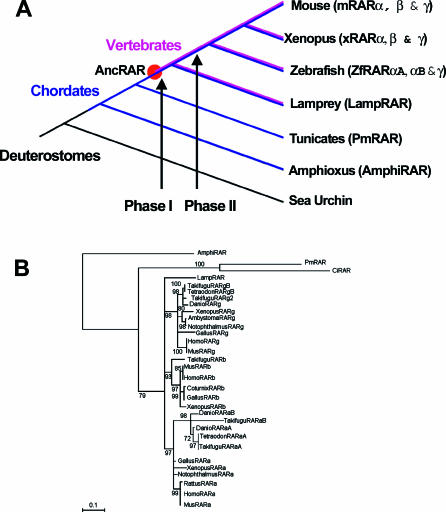
Phylogenetic View of Deuterostomes and RARs(A) Current view of deuterostome phylogeny with amphioxus representing the basal chordate [5]. RARs used in the present study are indicated at their respective taxonomic positions—for mouse, Xenopus, zebrafish, lamprey, amphioxus, and tunicates. The position of the synthetic ancestral sequence is indicated by a red circle. The two proposed periods of whole genome duplications in vertebrates are indicated as Phase I and Phase II, occurring respectively before and after the divergence of lampreys.(B) Phylogenetic tree showing the placement of the RARs used in this study. Branch length is proportional to evolutionary change (bar = 0.1 substitutions per site); numbers at nodes are bootstrap support, in percent of 1,000 replicates. Branches supported by bootstrap lower than 70% have been polytomised. The tree was rooted by the amphioxus sequence, in agreement with [5]. Species abbreviations and their groups are indicated as follows. Amphioxus: Amphi, Branchiostoma floridae. Tunicates: Pm, Polyandrocarpa misakiensis; Ci, Ciona intestinalis. Lampreys: Lamp, Petromyzon marinus. Teleost fish: Takifugu, Takifugu rubripes; Tetraodon, Tetraodon nigroviridis; and Danio, Danio rerio. Amphibians: Xenopus, Xenopus laevis; Ambystoma, Ambystoma mexicanum; and Notophthalmus, Notophthalmus viridescens. Birds: Gallus, Gallus gallus; and Coturnix, Coturnix coturnix. Mammals: Homo, Homo sapiens; Mus, Mus musculus; and Rattus, Rattus norvegicus.